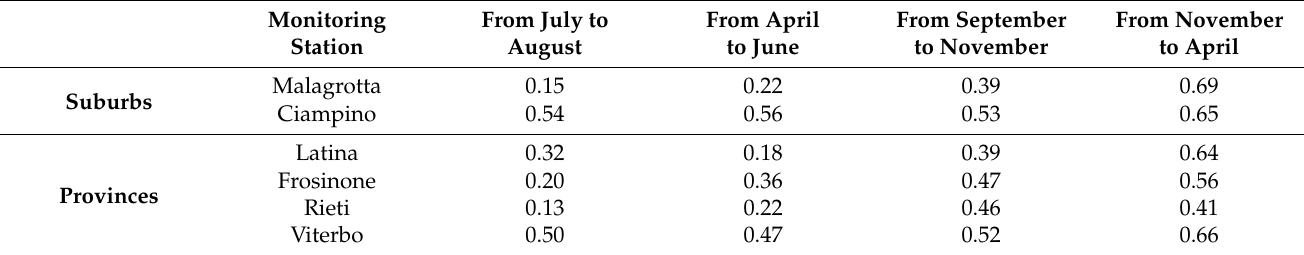
Table 4. Cross-correlation values between Roma Green Band and suburbs or province stations of [C 6 H 6 ] in 2015. Monitoring